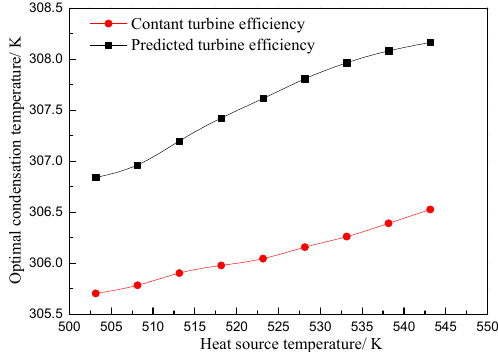
Figure 12. Optimal condensation temperature at different heat source temperature. Figure 11. Optimal evaporation temperature at different heat source temperature.